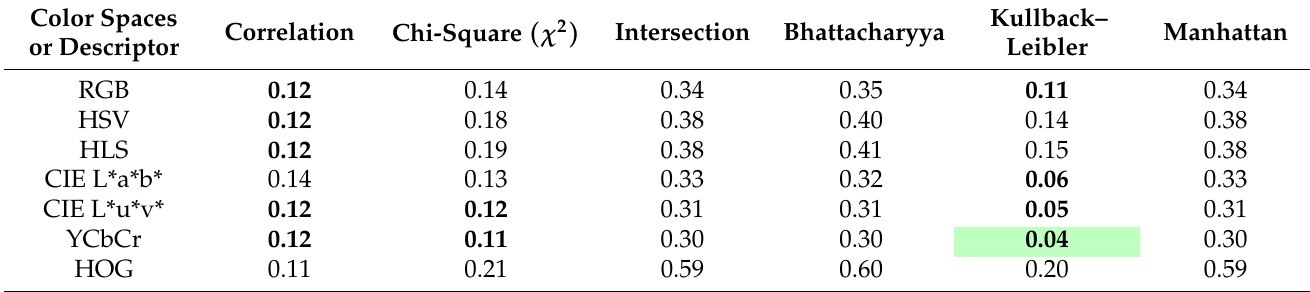
Table 6. S scores calculated for the 2nd video with 2 people.